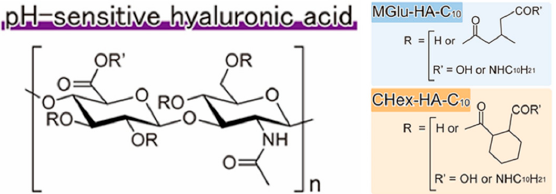
Figure 3. Structures of pH-sensitive modified hyaluronic acid derivatives. Reproduced